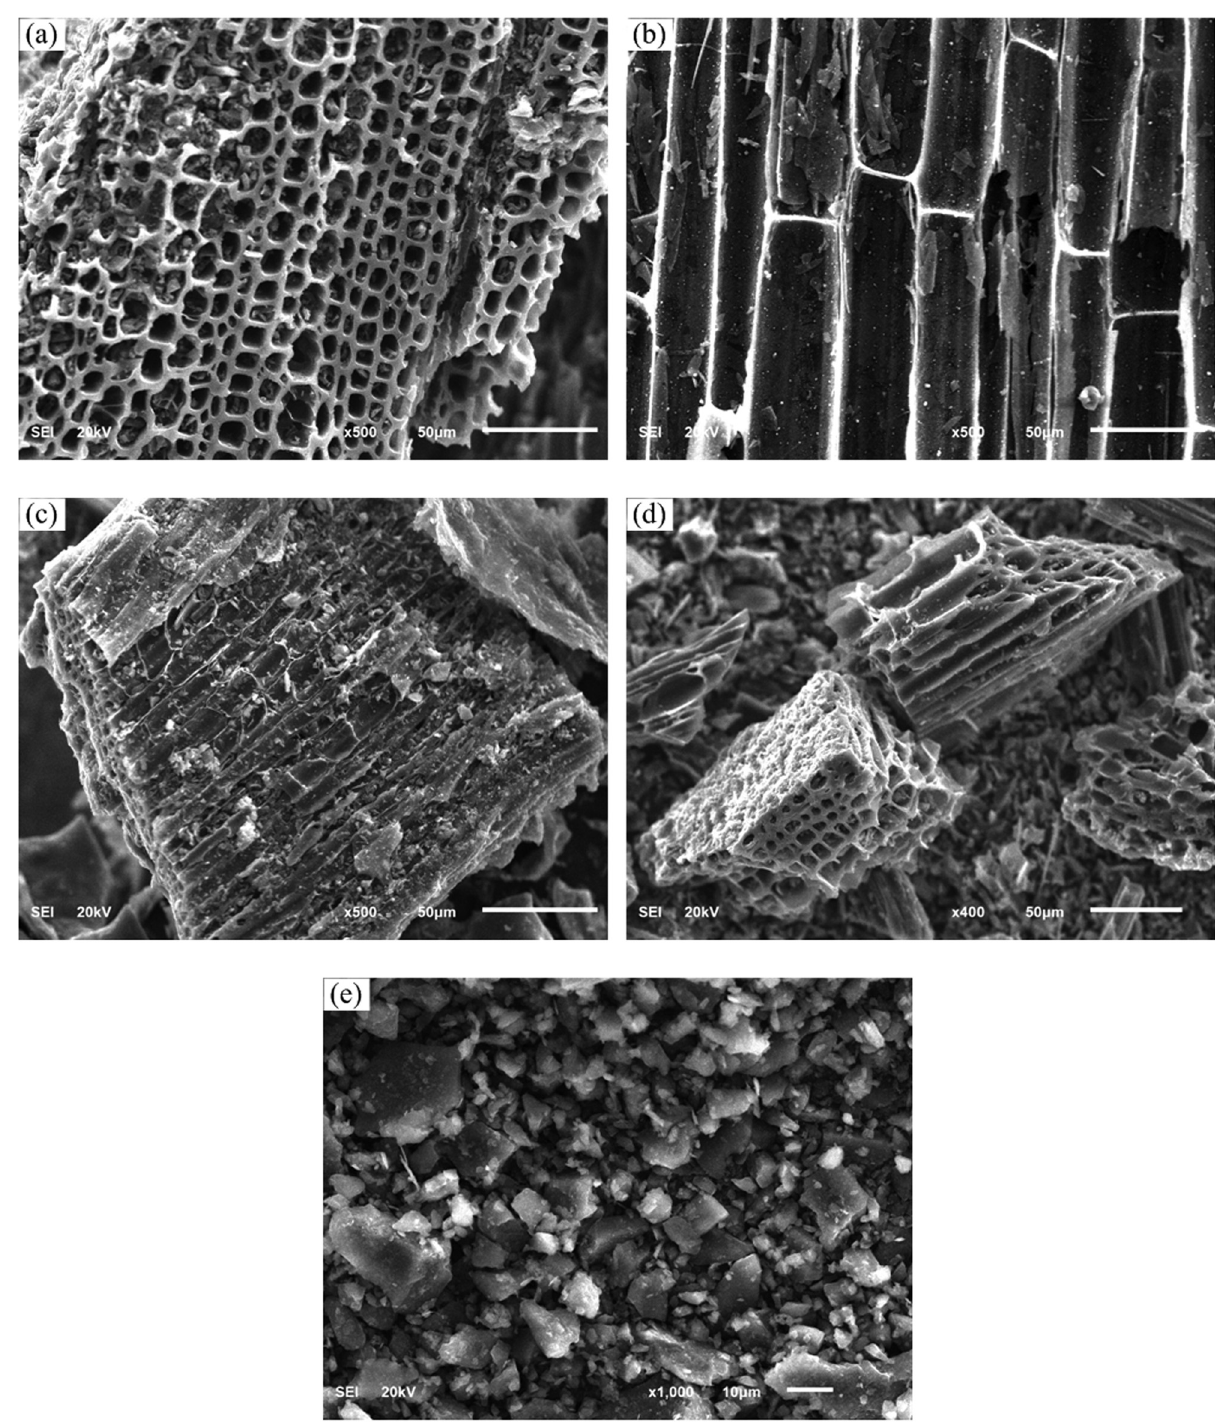
Figure 1: SEM images of samples: ( a ) SD - char; ( b ) WS - char; ( c ) RH - char; ( d ) BB - char and ( e )